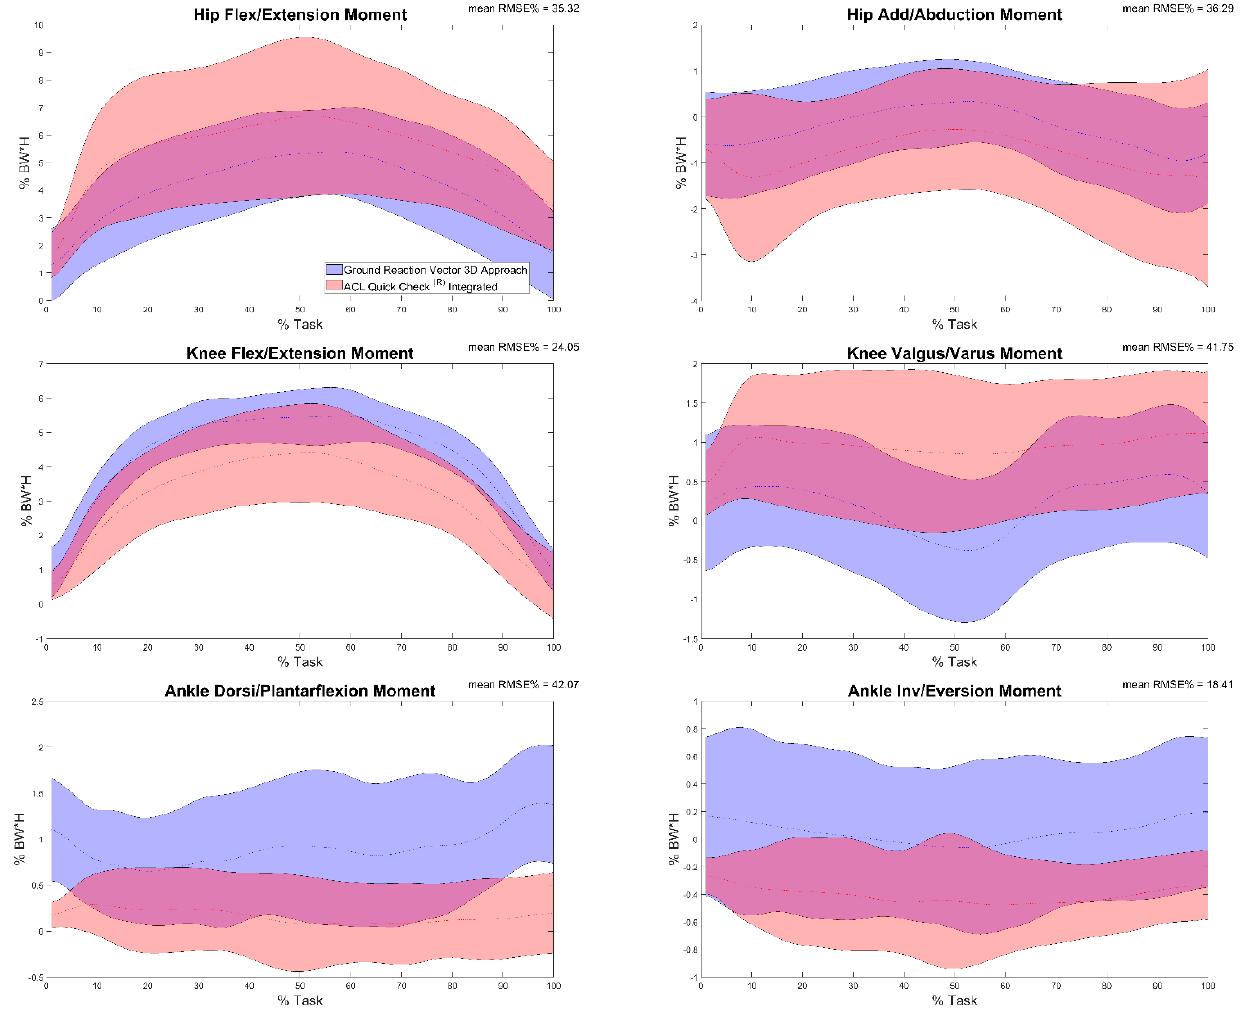
Figure 6. Hip, knee and ankle adduction/abduction and flexion/extension moments during the task calculated through the Ground Reaction Vector 3D approach (blue) and through ACL Quick Check ® integrated (red) and mean of RMSE% of the comparison between the two. Averages plus and minus one standard deviation are reported as colored bands.